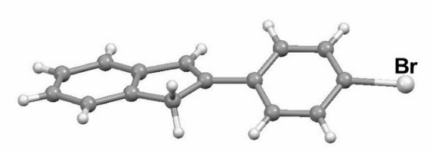
Figure 7. Molecular structure of 2-(4-bromophenyl)indene, 11